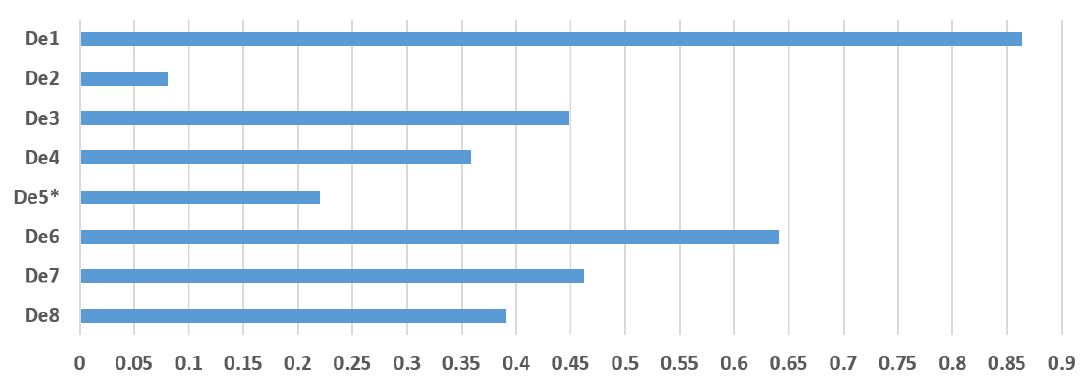
Figure 4. Mean values of D e 1– D e 8. * For D e 5 we have N1 = 250.